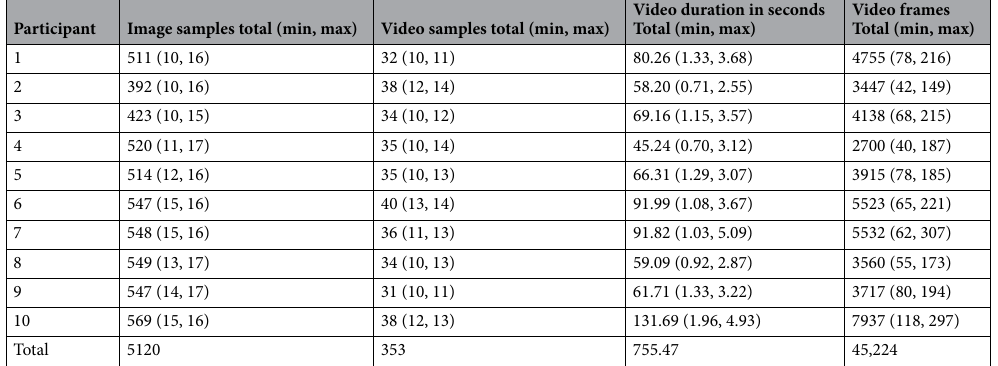
Table 2. PSL data per participant and total collected